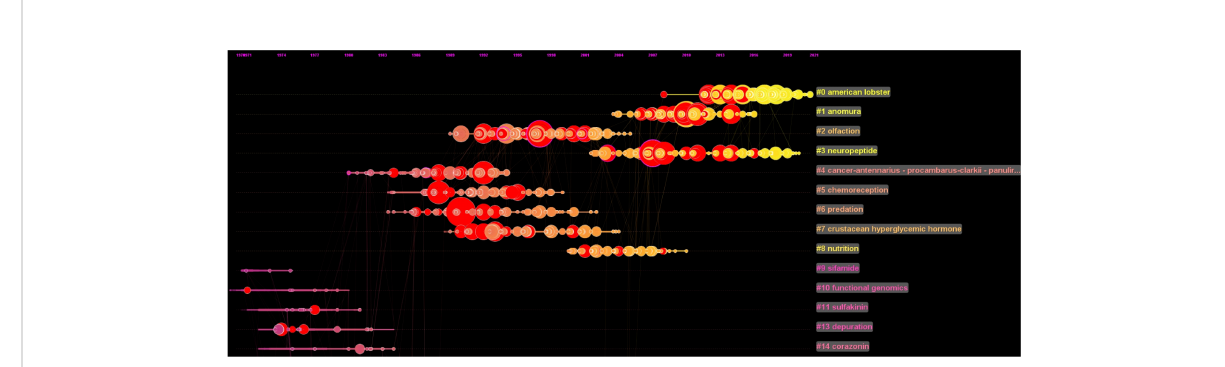
FIGURE 8 Summary of 14 identi fi ed document cluster lifetimes (solid lines). Cluster labels were generated from